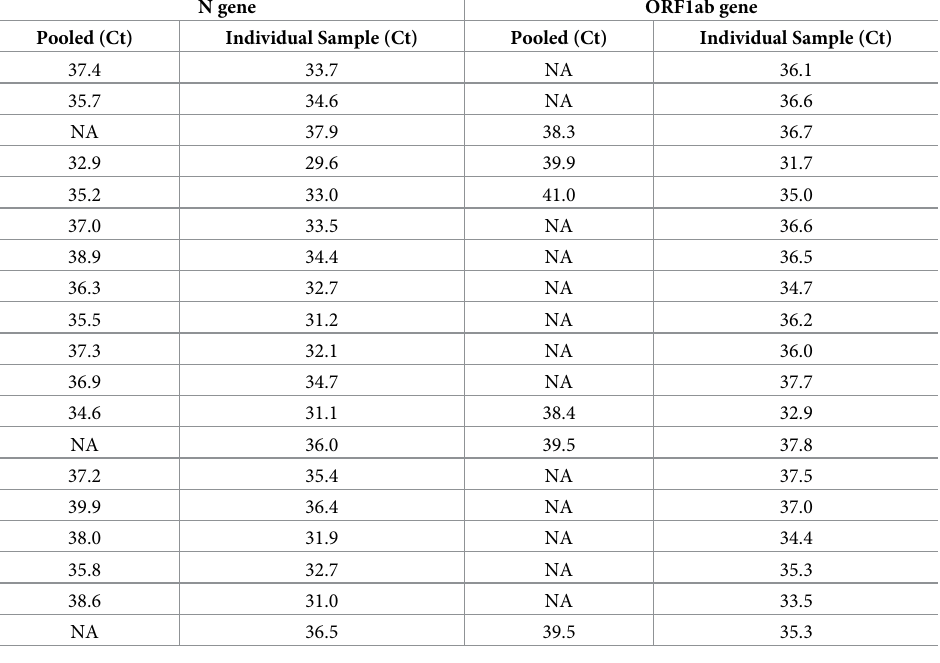
Table 1. Ct values of positive individual samples from 19 indeterminate pools. N